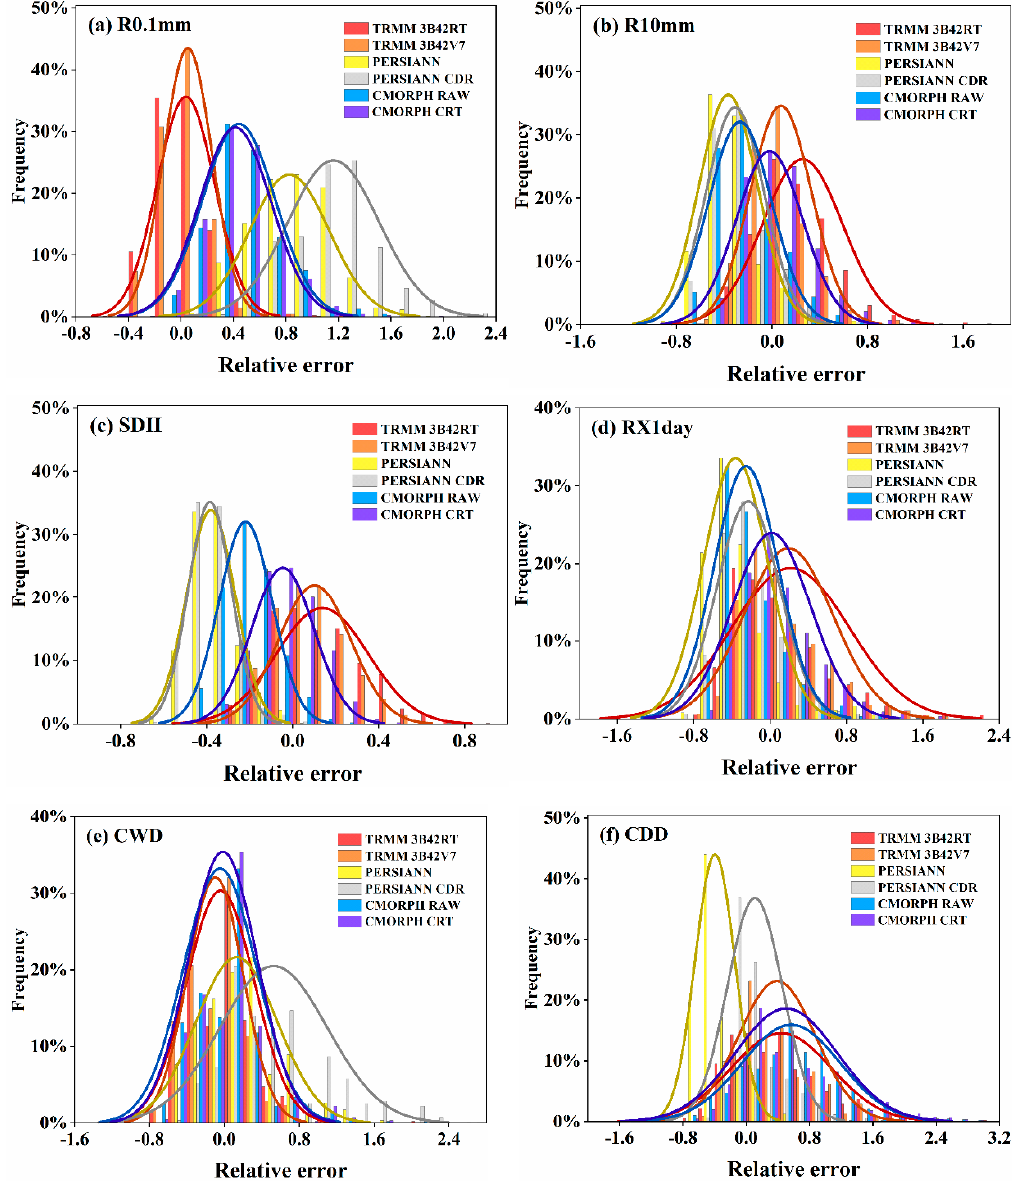
Figure 10. Extreme precipitation index ( a ) R0.1mm, ( b ) R10mm, ( c ) SDII, ( d ) RX1day, ( e ) CWD and ( f ) CDD frequency distribution histograms and distribution curves for the six SPPs.